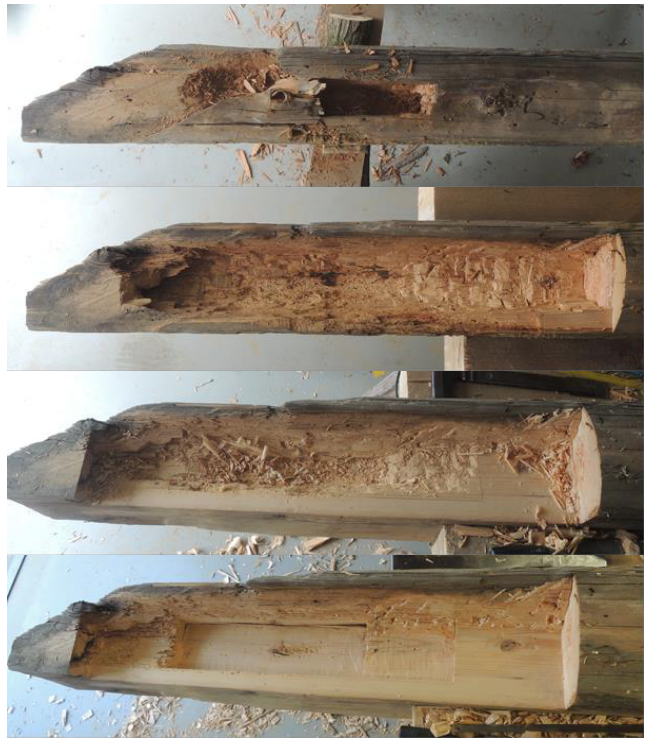
Figure 28. The gradual formation of the bed for the insert copying the damage area.